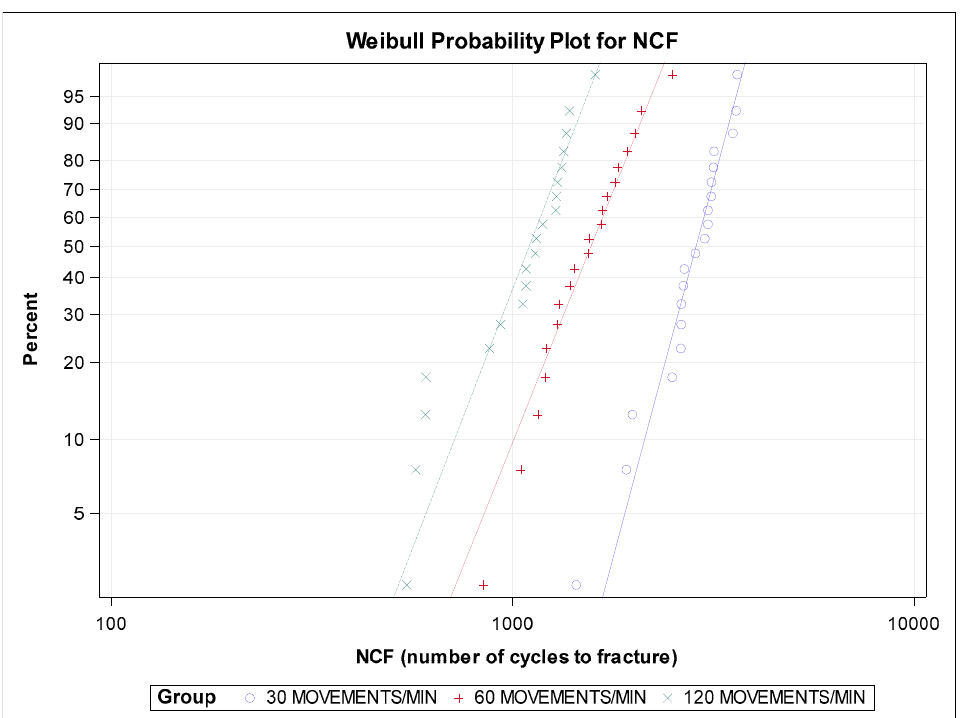
Figure 6. Boxplots of the NCF of the experimental groups. The horizontal line in each box represents the median value. J. Clin. Med. 2020 , 9 , x FOR PEER REVIEW